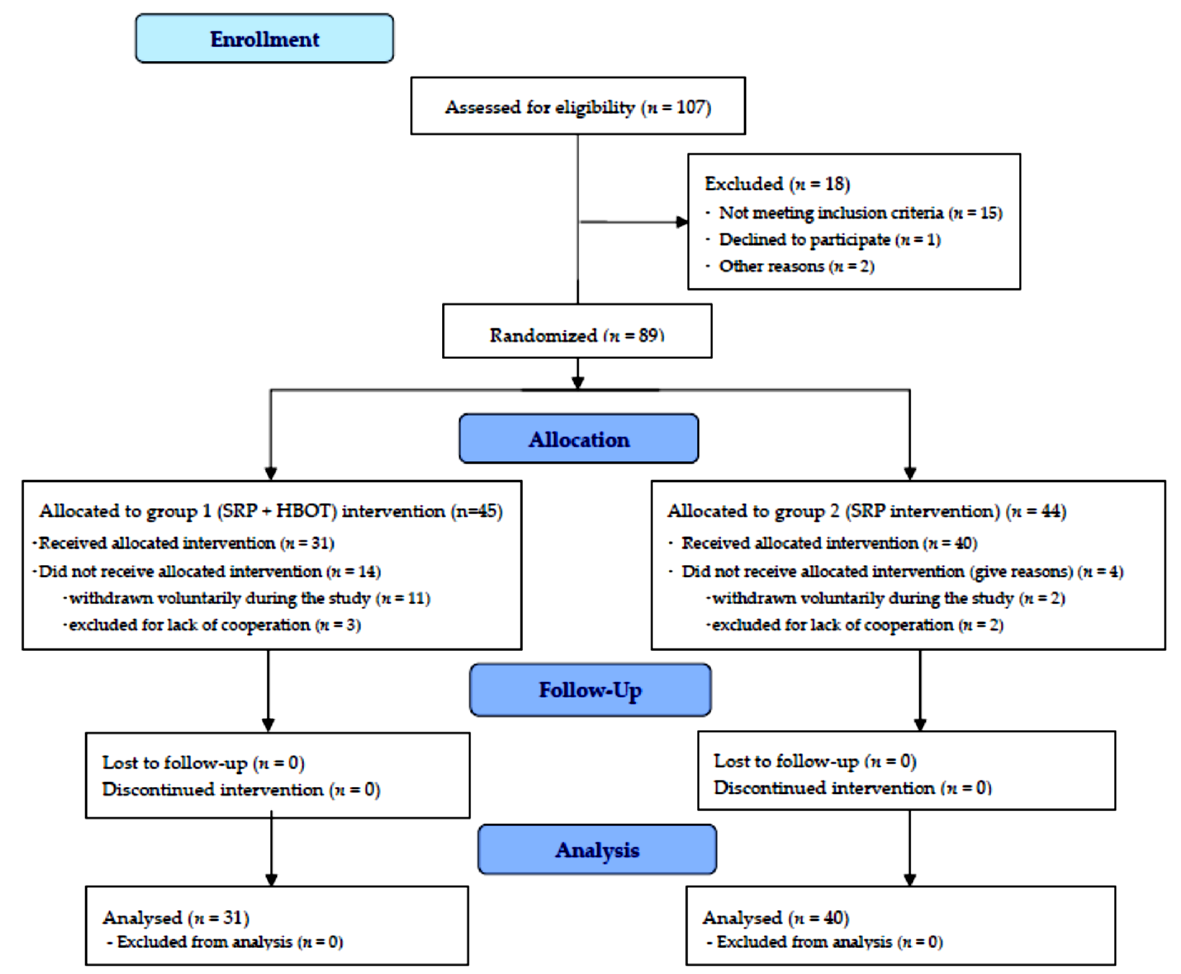
Figure 1. Flow Diagram of the study.